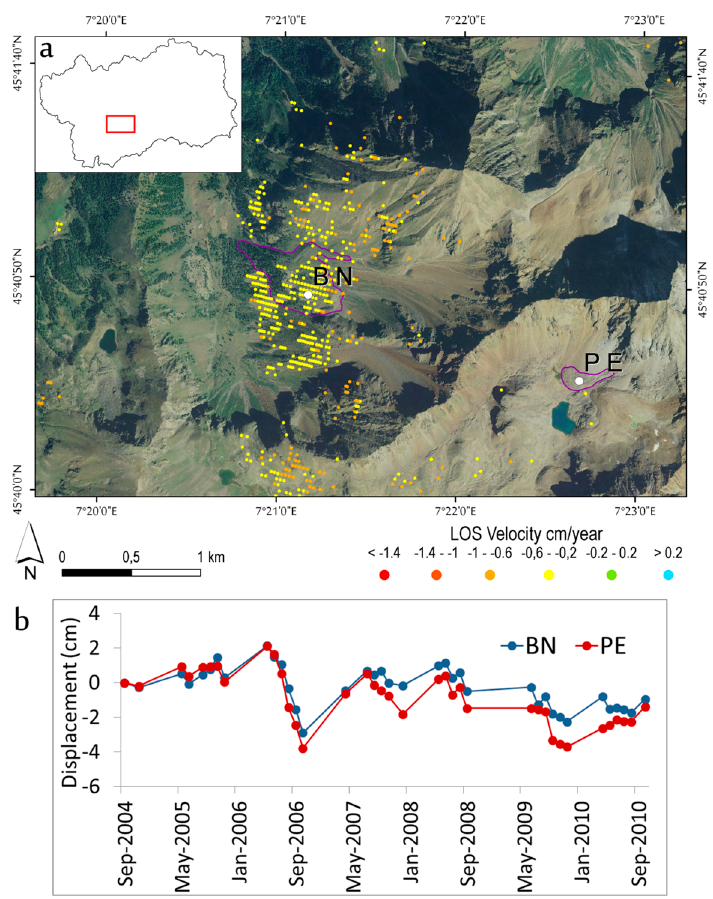
Figure 10. ( a ) Mean deformation velocity map of the Becca de Nona (BN) and Petit Emilius (PE) rock glaciers in descending orbit; ( b ) time series corresponding to the targets signed by the white dots in the map.